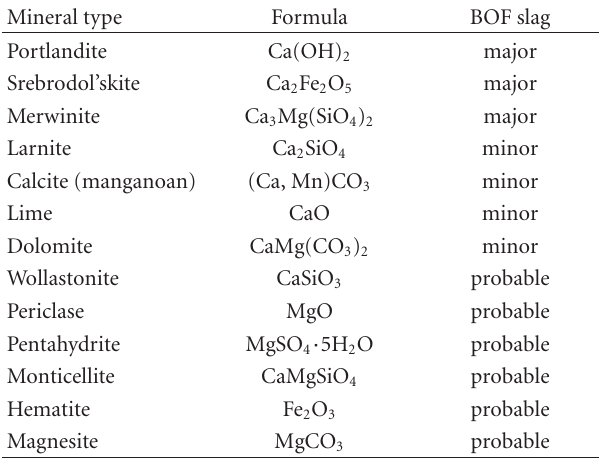
Table 4: Mineralogical phases identified in BOF slag based on XRD analyses.